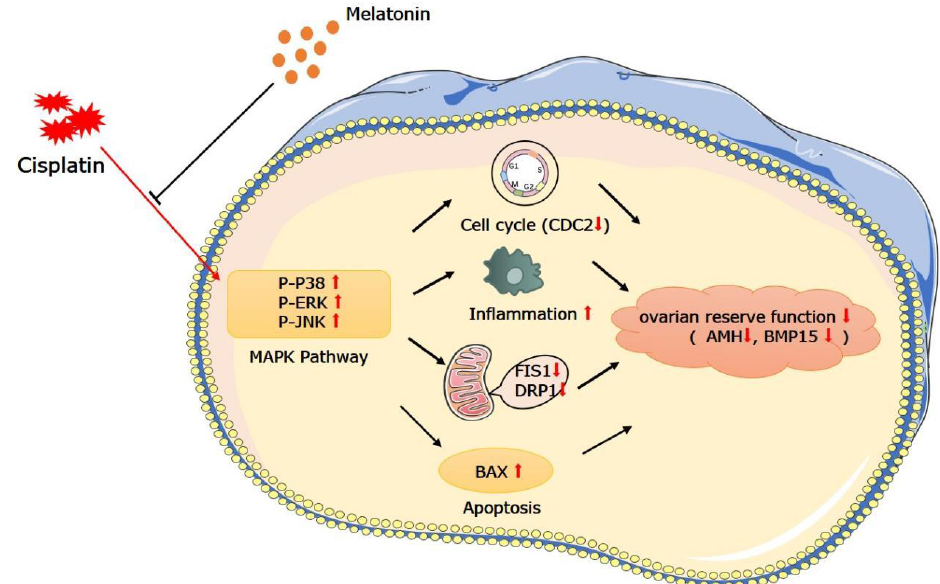
Figure 6. Schematic representation of the protective effect and mechanism of melatonin on CP-induced ovarian damage in mice.